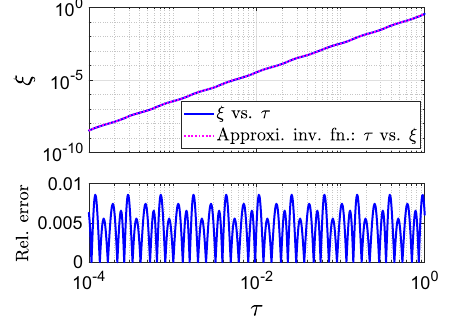
Fig. 5 Upper panel: ξ vs. τ by Eq. (25) and the approximate inverse function τ vs. ξ by Eq. (27). For both curves in the upper panel, the horizontal axis is for τ , and the vertical one is for ξ . Lower panel: The relative error for the two curves in the upper panel